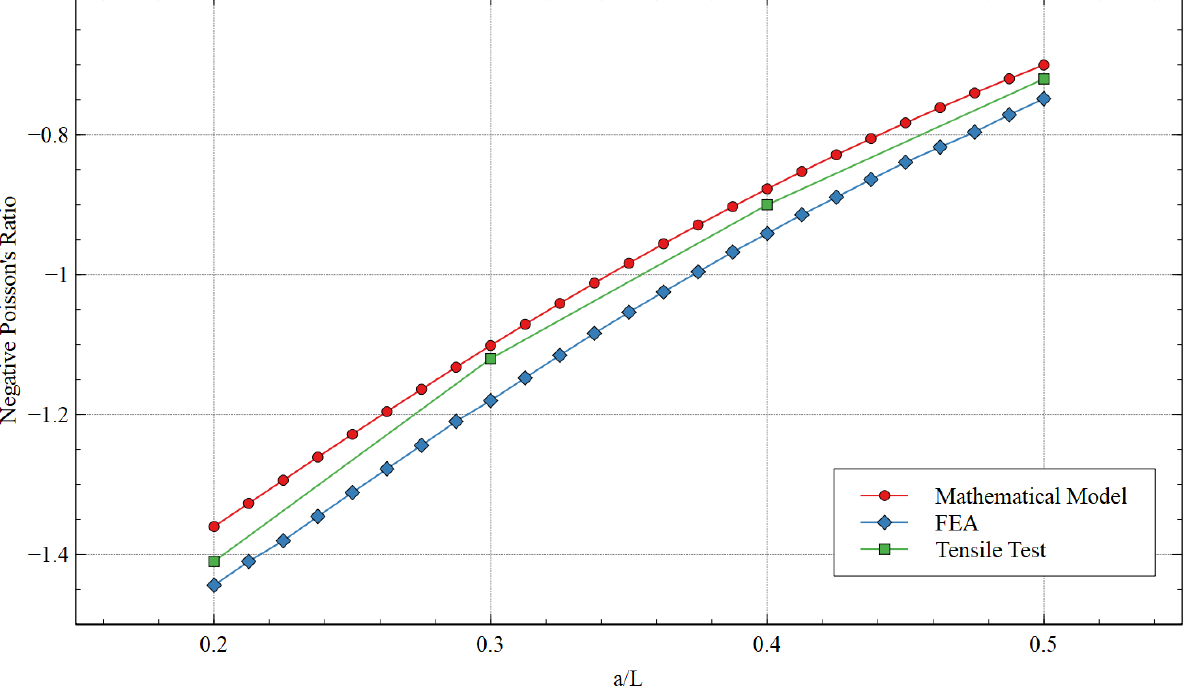
Figure 16. Comparison of Poisson’s ratio obtained from the FEA and mathematical model for vary- ing angle θ for y-direction loading. Contrary to x-direction loading, here it can be observed that the NPR increased with the value of H/L (see the arrow direction in Figure 15). Similarly, it can be noticed that NPR increases as the re-entrant angle decreases (see the arrow direction in Figure 16). Comparing the structure with the re-entrant honeycomb model, we can see that, in this specific case, better NPR can be achieved using the re-entrant honeycomb model. 5.1.3. Comparison of NPR The combined effect on NPR calculated using the mathematical model for the varia- tion of H/L , a/L , and re-entrant angle for both loading directions is shown in Figure 17. In general, when the loading was applied in the x-direction, the NPR was improved with low values of H/L , re-entrant angle, and higher values of a/L . This was because the added